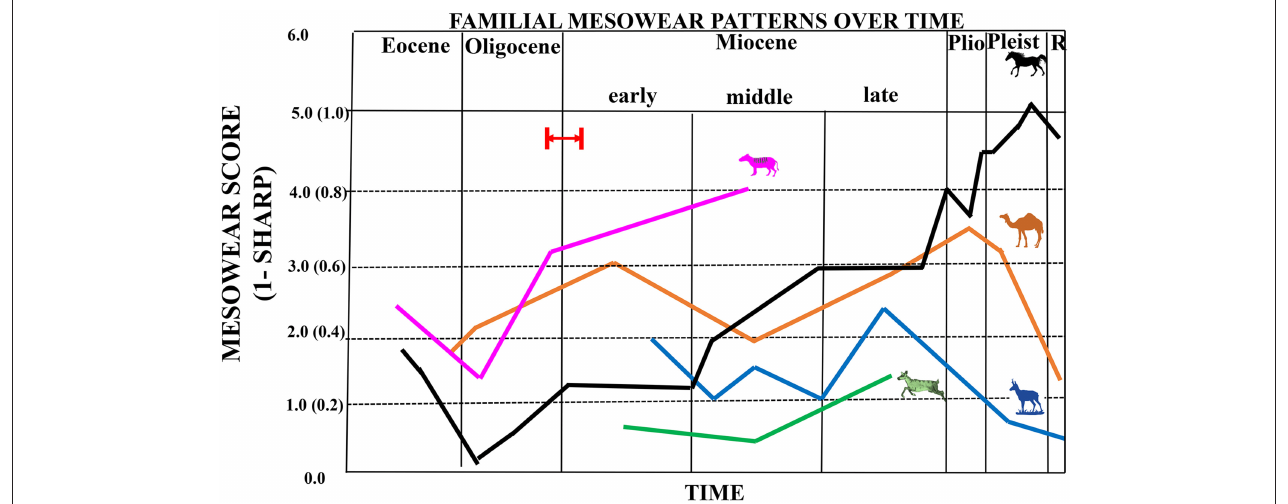
FIGURE 6 | Composite figure showing mesowear trends through time for equids (black line), antilocaprids (blue line), camelids (orange line), dromomerycids (green line), and oreodonts (pink line). Equid, camelid, antilocaprid, and dromomerycid trends reflect a graphical display of average mesowear scores (scores that combine cusp shape with occlusal relief) for taxa in a particular time period (0–6); merycoidodontid trend reflects cusp shape only (i.e., the proportion of cusps that are not sharp, 0–1.0). Red arrow and red lines indicate probable timing of first availability of grass in the North American Great Plains Region by ∼ 22 million years ago (earliest Miocene), but possibly by even about 26 million years ago (latest Oligocene) based on phytolith data from Strömberg (2011).